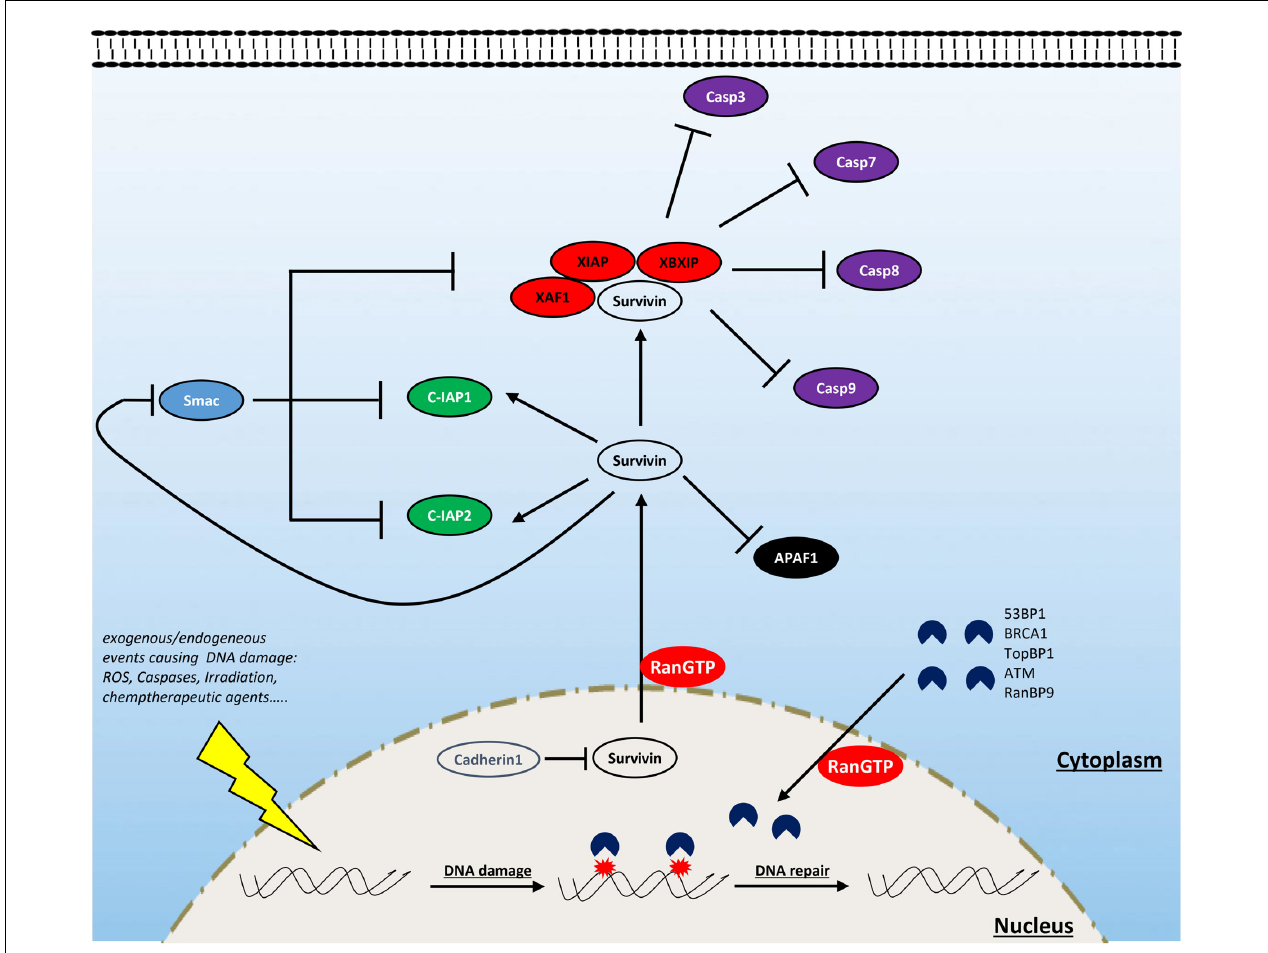
FIGURE 3 | Involvement of Ran in resisting cell death. Ran is involved in resisting cell death through the interaction with survivin and some components of the DNA damage response (DDR). Ran participates in the export of survivin from the nucleus (which is rapidly destabilized by cadherin 1) to the cytoplasm. Cytoplasmic survivin plays a critical role in cell survival by inhibiting proapoptotic factors: while it participates in the formation of a complex with some inhibitors of apoptosis proteins (IAPs) (notably XAF1, XIAP, and XBXIP) to inhibit the activity of caspases 3, 7, 8, and 9, it enhances the activity of other factors such as C-IAP1 and C-IAP2. Furthermore, survivin antagonizes the release of apoptotic protease-activating factor 1 (APAF1) from the mitochondria and constrains the action of the IAP inhibitor Smac. Ran is also an active player of the DDR which is activated following the exposure of cells to endogenous or exogenous DNA-damaging factors [i.e., reactive oxygen species (ROS), caspases, irradiation, and chemotherapy]. During this process, Ran participates in the import of critical components of the DDR such as ATM, BRCA1, TopBP1, and